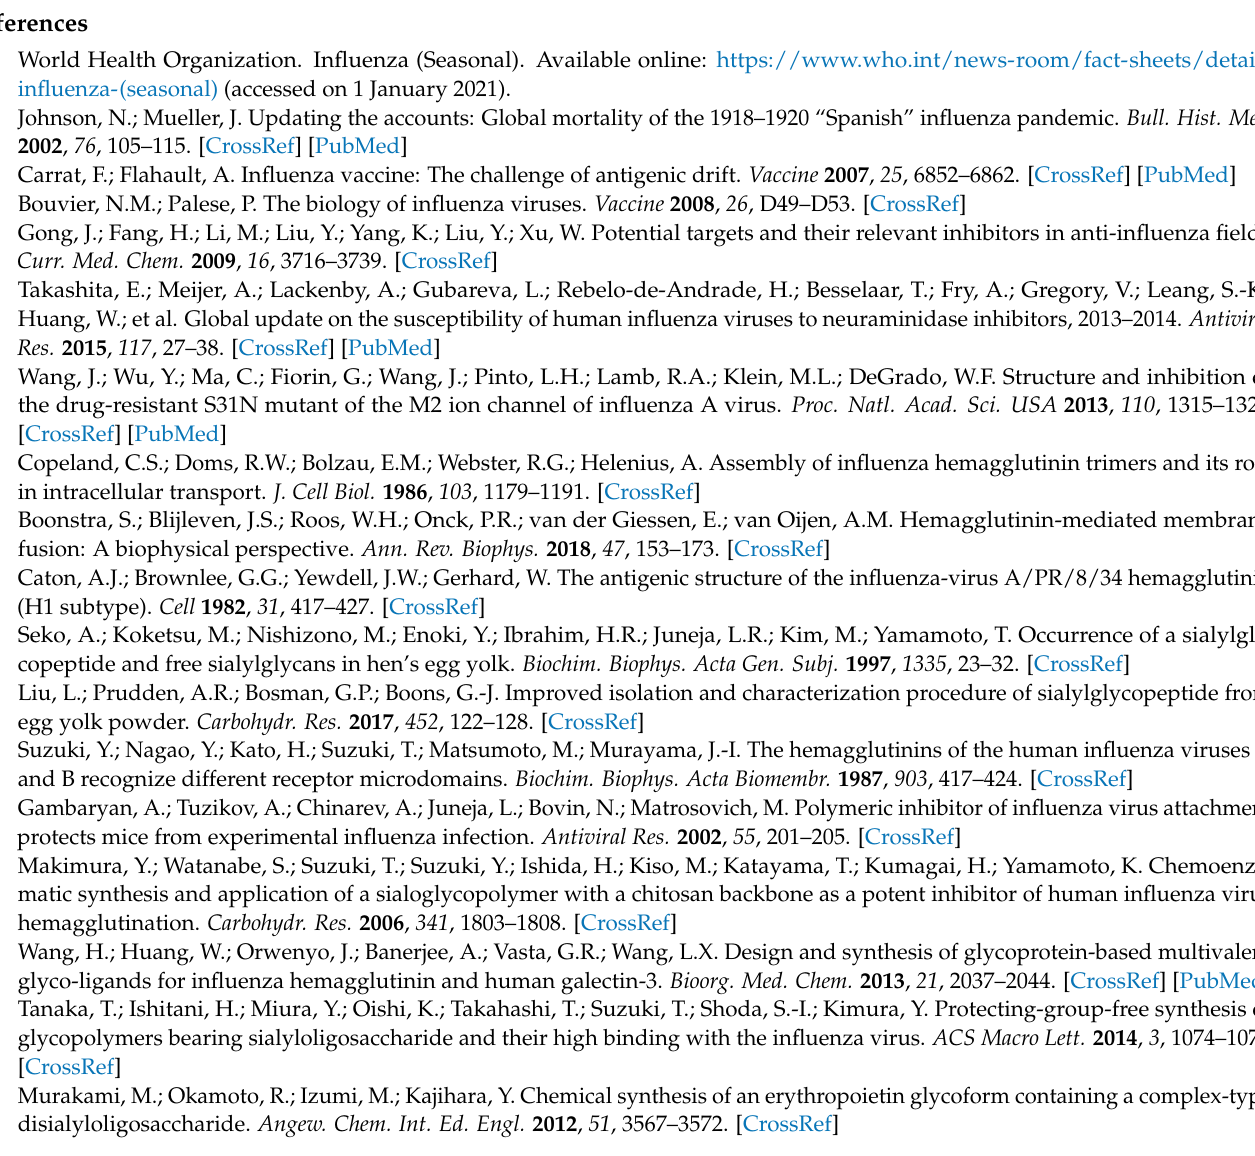
pentacyclic triterpene-N3. Figure S2: Chemical structures of four SCT-Asn-pentacyclic triterpene. Figure S3: SPR assay to determine the affinity of compounds to H1N1 (A/WSN/1933) protein immobilized on a CM5 sensor chip. Figure S4: SPR assay to determine the affinity of compounds to H5N1 (A/Hong Kong/483/97) protein immobilized on a CM5 sensor chip. 1 H-, 13 C-NMR, and MS spectra of intermediate and final products. High resolution mass spectra of four